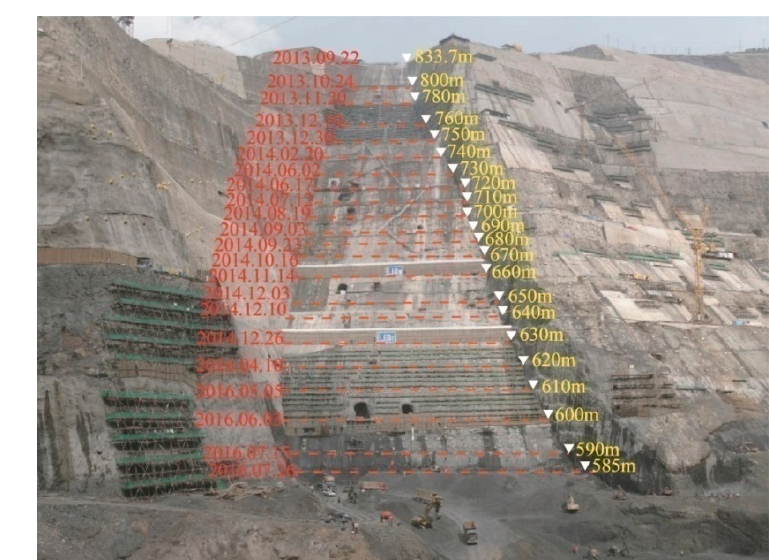
Figure 6. Detailed excavation schedule of the rock